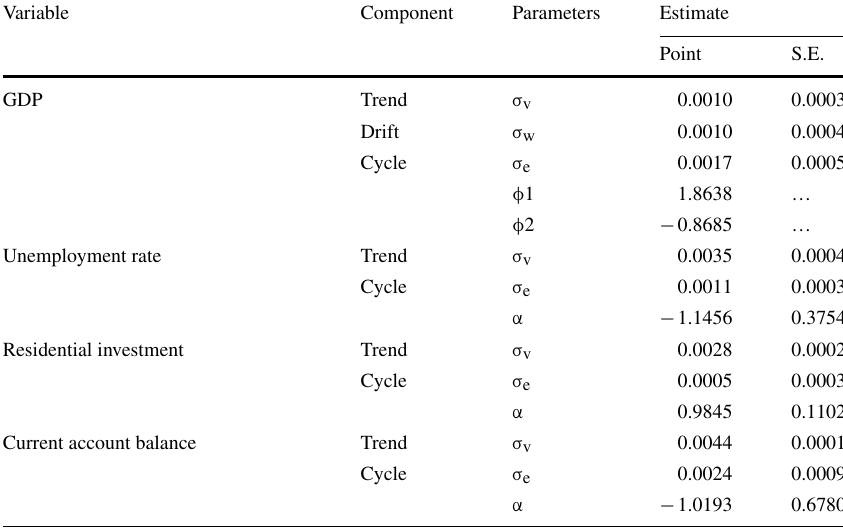
Table 3 Final ML estimation of the multivariate (v4) model. Source of data : author’s